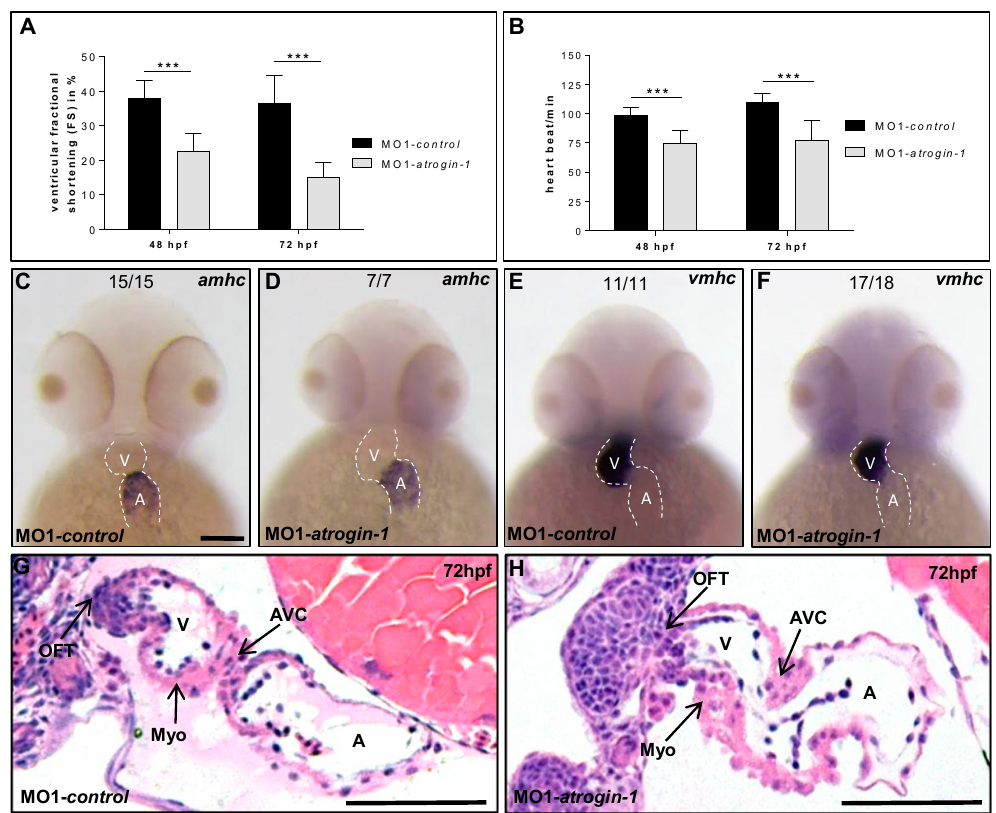
Figure 4. Impaired heart function in Atrogin-1-deficient embryos. ( A ) Fractional shortening (FS) measurements of the ventricular chambers of Atrogin-1 morphants and embryos injected with control Morpholino at 48 and 72 hpf; ( B ) Heart beat per minute of MO1- control compared to MO1- atrogin-1 injected embryos measured at 48 and 72 hpf. Data represent means ± SD, student´s t -test, *** p < 0.0001 ( A , B ); ( C – F ) Whole-mount antisense RNA in situ hybridization against atrial myosin heavy chain ( amhc ) and ventricular myosin heavy chain ( vmhc ) demonstrates unaltered mRNA expression in Atrogin-1 morphants at 48 hpf, scale bar = 50 µm; ( G , H ) H&E-stained sagittal histological sections shows normal heart morphology in MO1- control and MO1- atrogin-1 morphant hearts at 72 hpf. Atrium (A), ventricle (V), myocardium (Myo), atrio-ventricular canal (AVC) and outflow tract (OFT), scale bar = 50 µm.